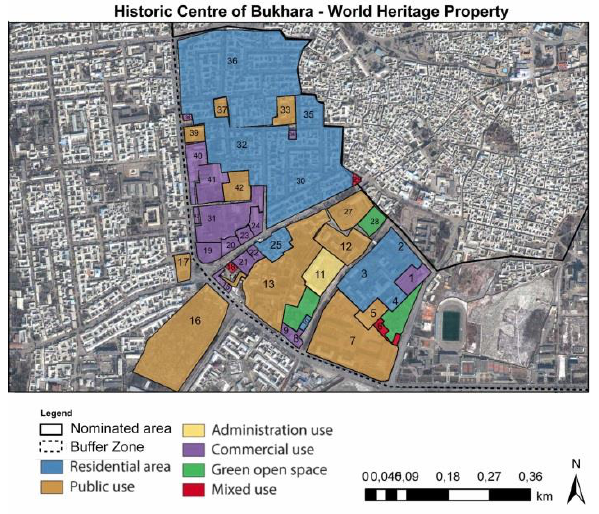
Figure 15. Example of photos of boundaries verification in Bukhara © UNESCO Field survey project (2013) As shown in Figure 16, the buffer zones were surveyed by zones. This assessment aimed to identify the land use, height of buildings, green and open areas, and the important architectural assets that are related to the historic center core area.